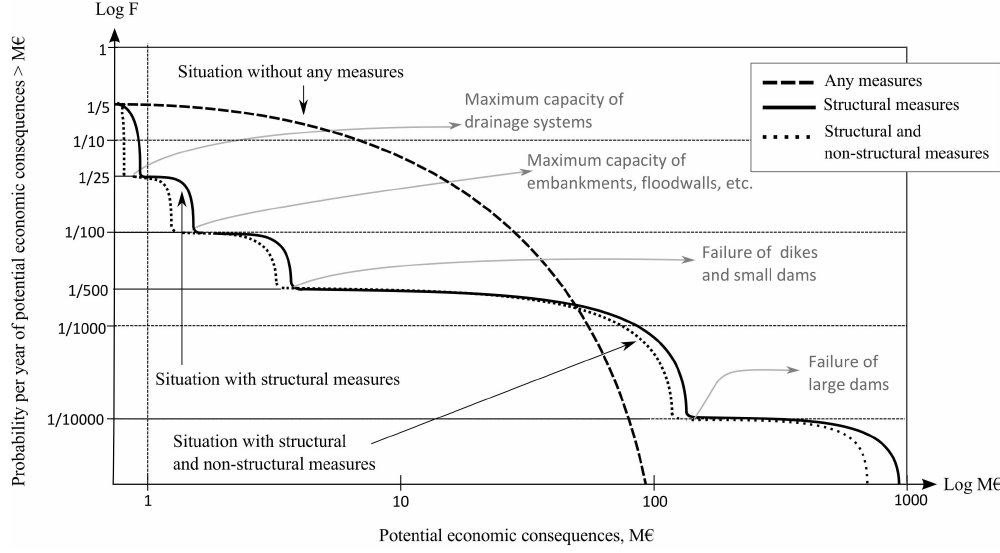
Fig. 1. Example of FD-curves of a hypothetic case study (Escuder-Bueno et al.,